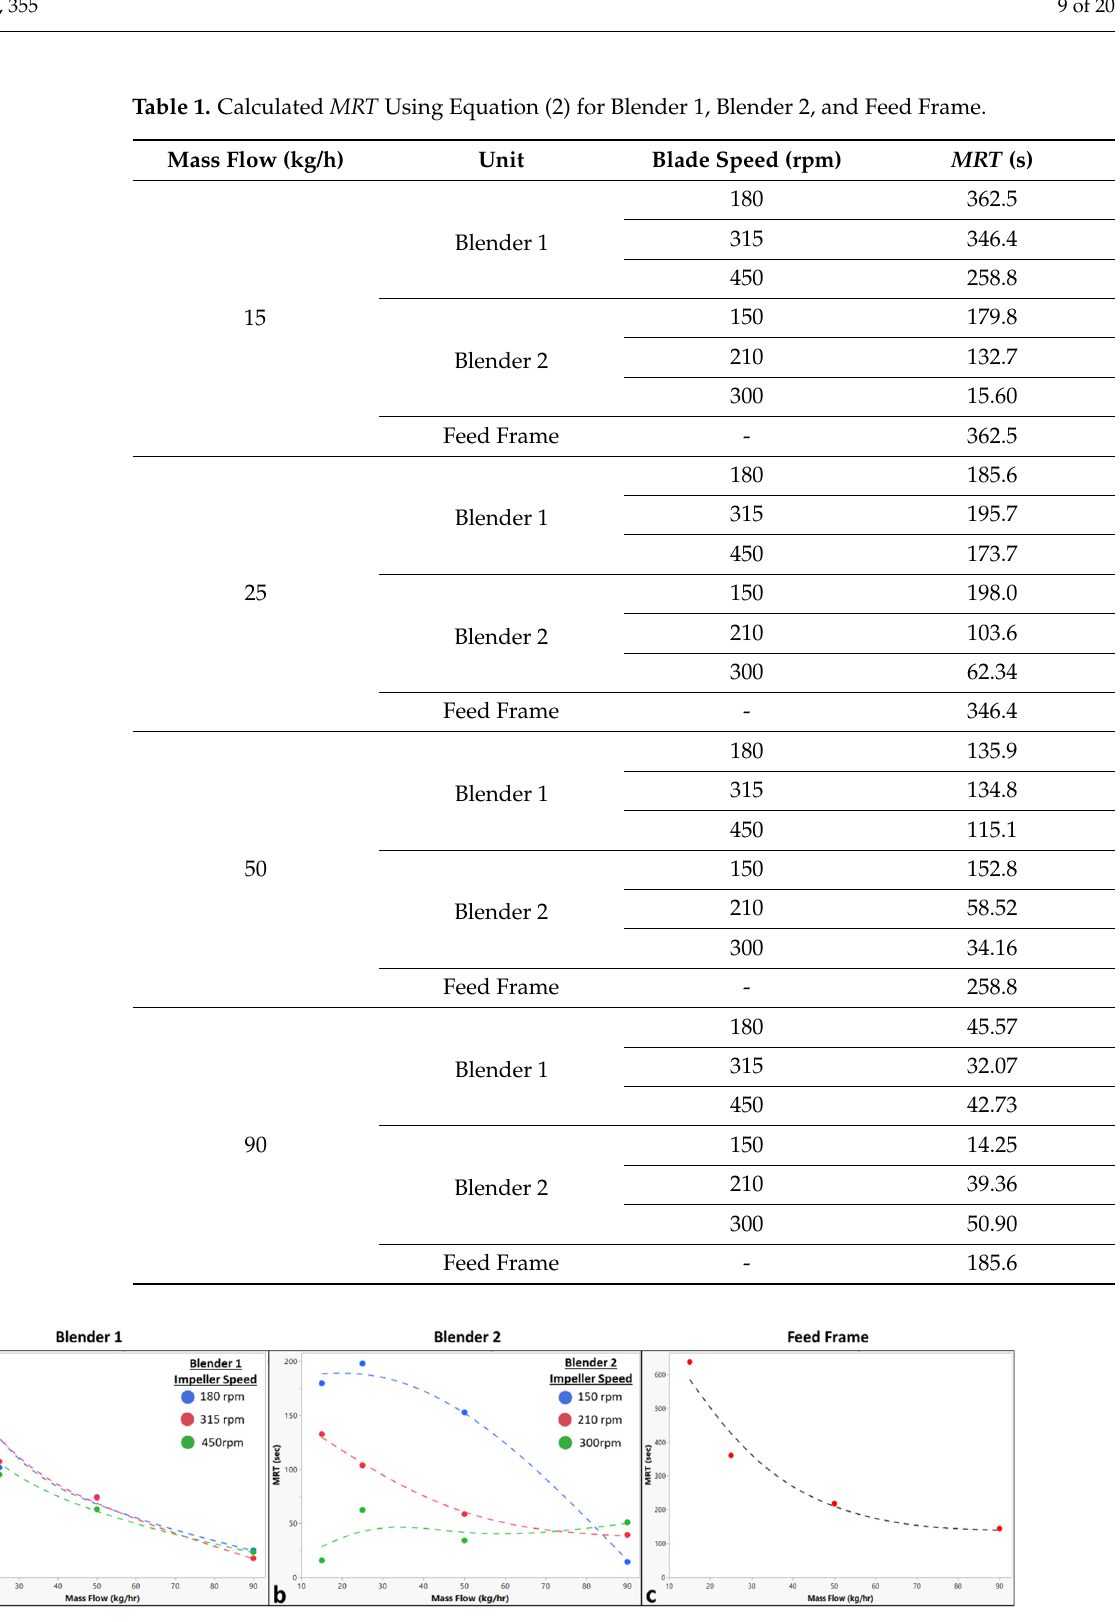
Figure 6. Plots of the calculated mean residence time for each blending unit. ( a ) Plot for the calculated Blender 1 mean residence time versus the total system mass flow rate with series at Blender 1 impeller speed. ( b ) Plot for the calculated Blender 2 mean residence time versus the total system mass flow rate with series at Blender 2 impeller speed. ( c ) Plot for the calculated feed frame mean residence time versus the total system mass flow rate.